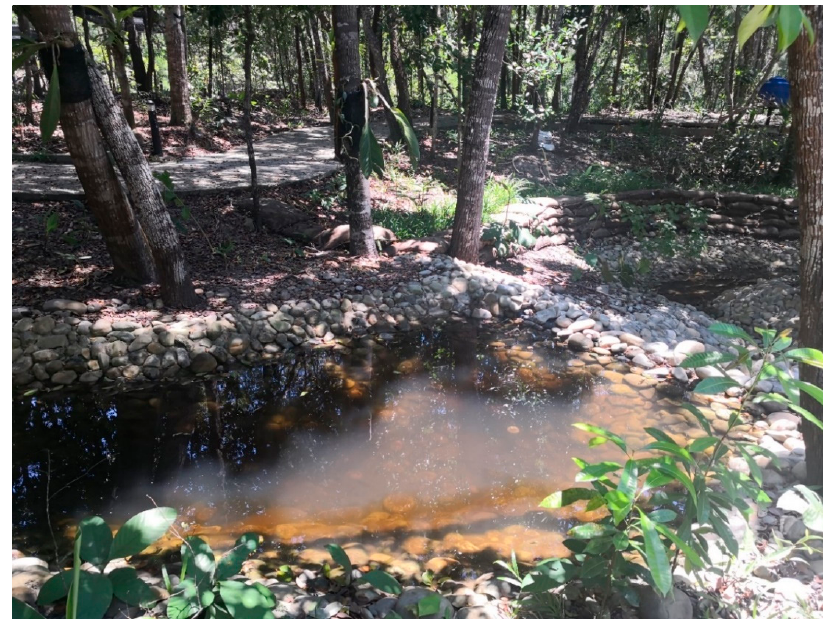
Figure 8. Testing site.